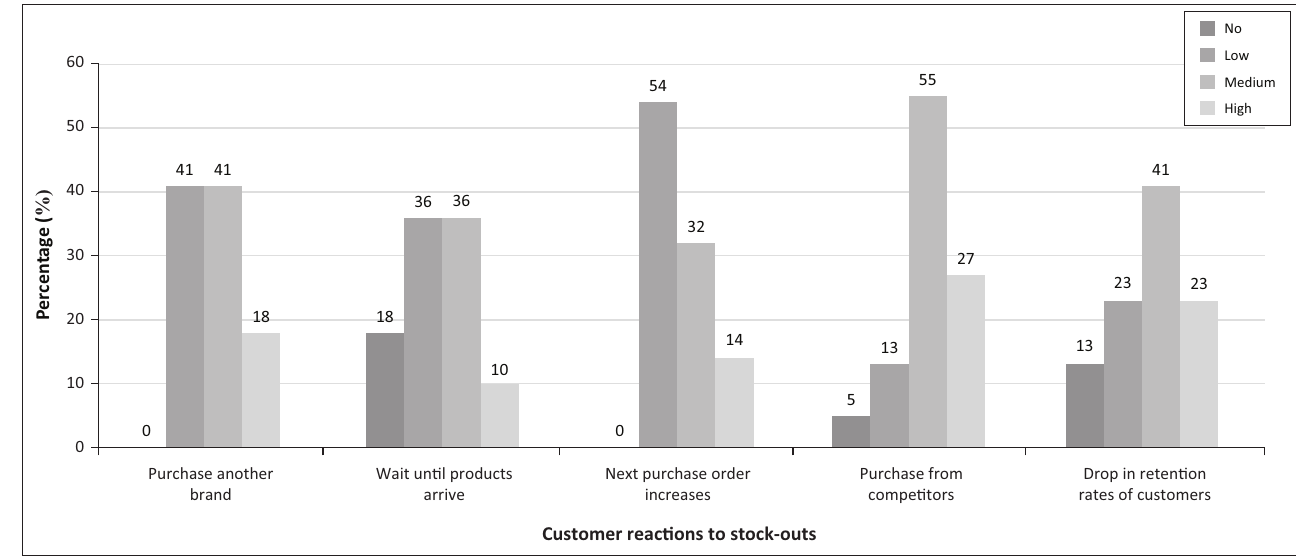
FIGURE 6: Customer reactions to stock-outs (respondents’ rating in %